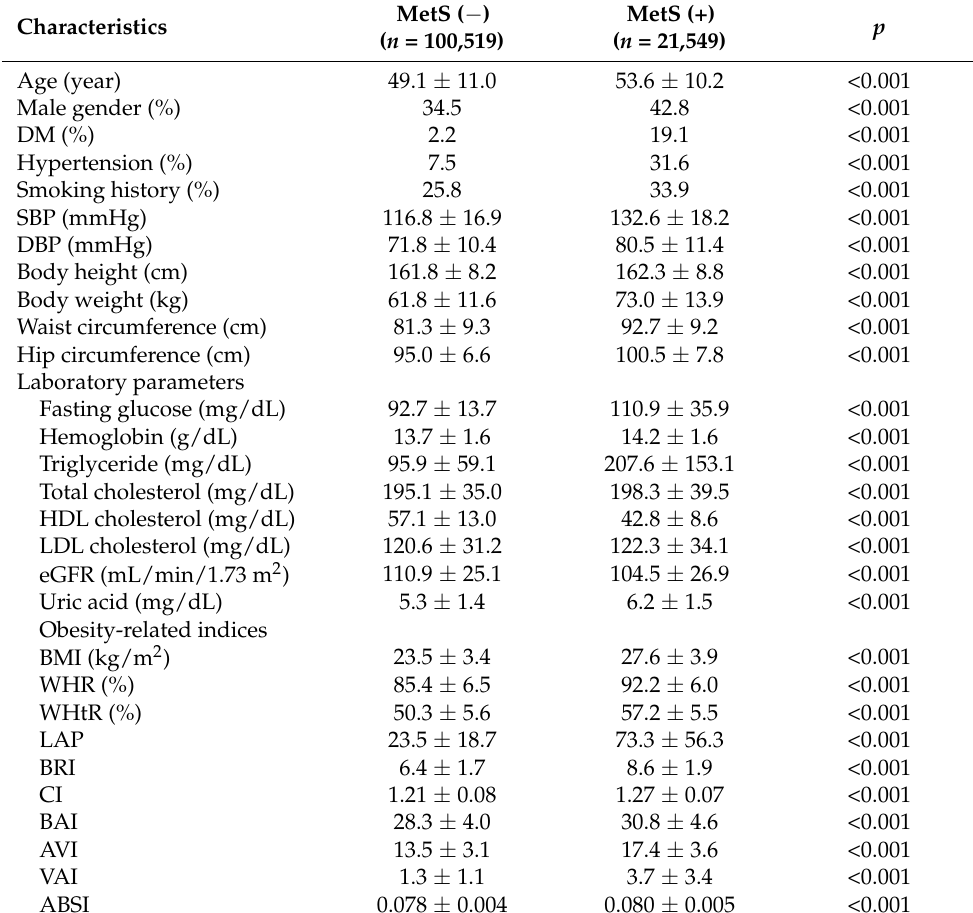
Table 2. Comparison of clinical characteristics among participants according to baseline